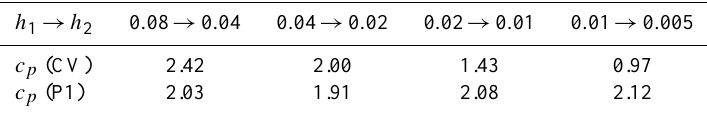
Table 1. Spatial order of convergence results for the method of manufactured solutions advection-diffusion test case described in Sect. 4.1.1. The difference between the analytical and numerical solutions using a first-order control volume (CV) discretisation and a second-order piecewise-linear Galerkin (P1) discretisation are calculated in the L 2 norm. The ratio between these on two spatial mesh resolutions, h 1 and h 2 , are used to estimate the order of spatial convergence of the model for this problem. The expected order of convergence, or better, is observed for both spatial discretisations. h 1 → h 2